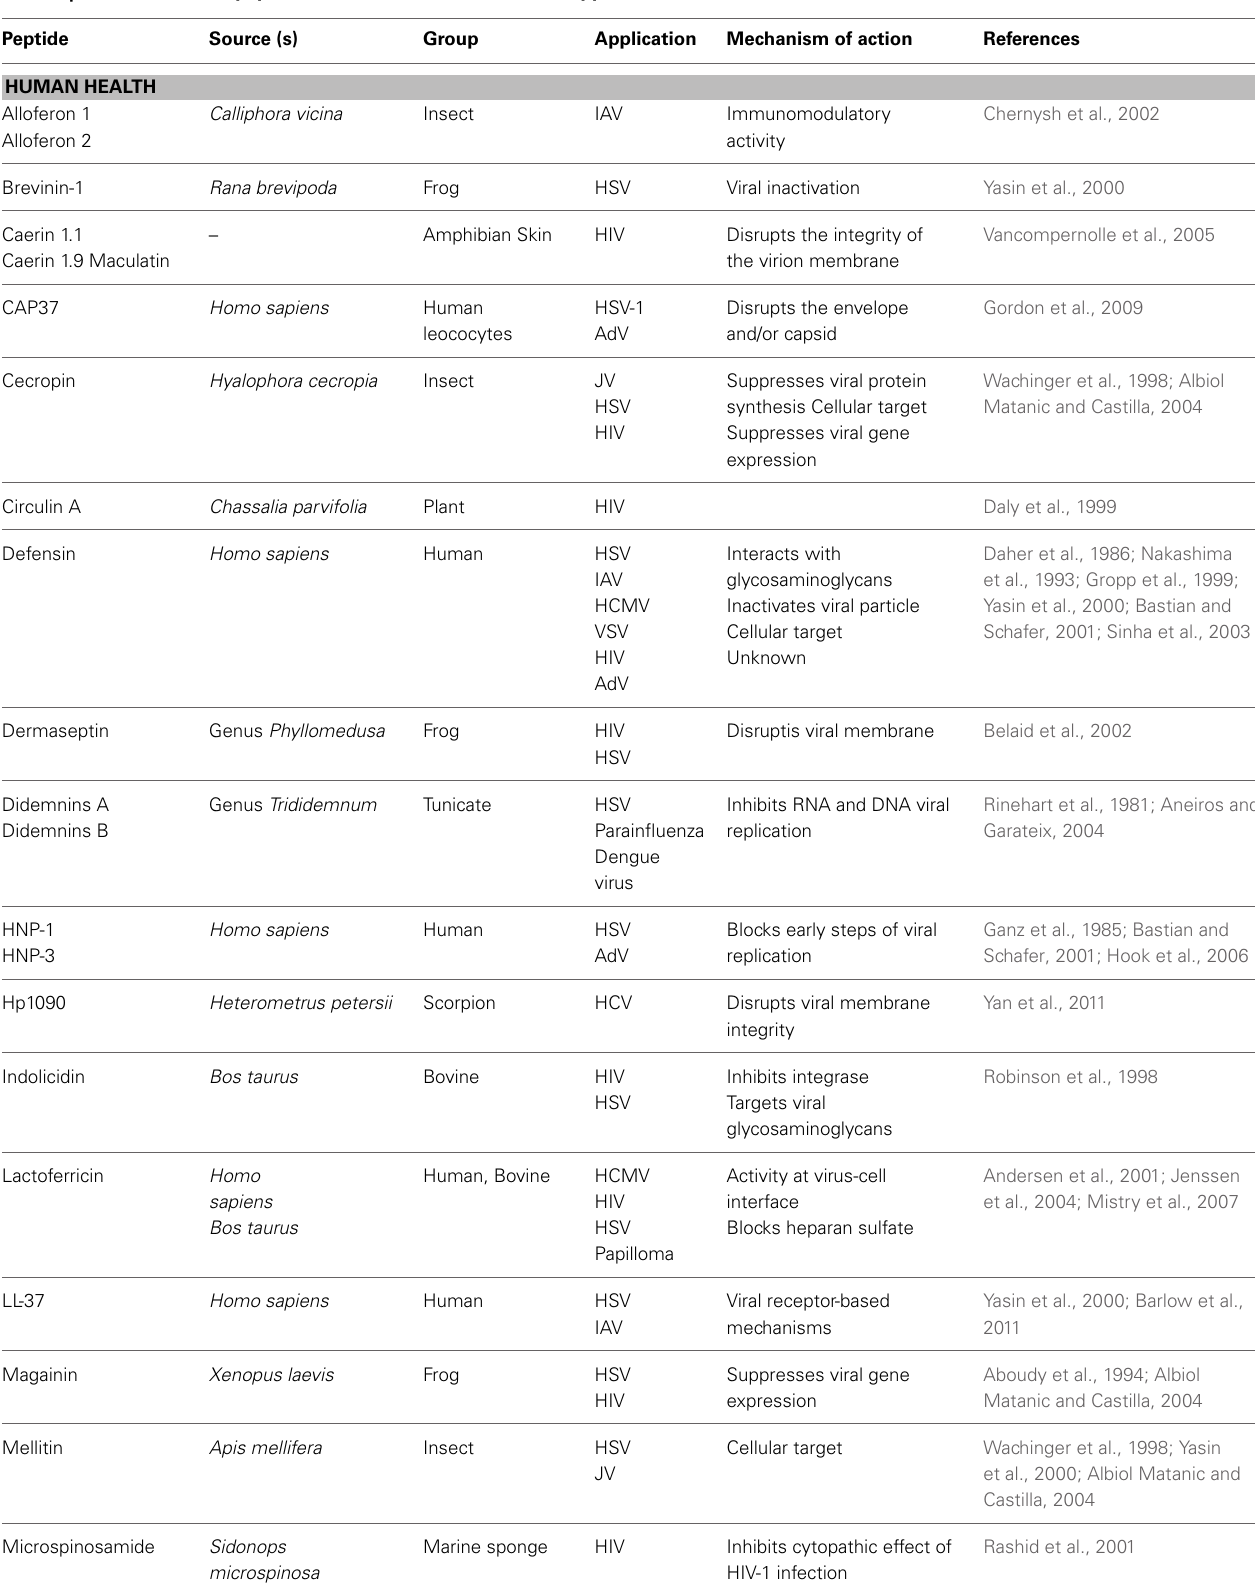
Table 2 | Cationic antiviral peptides from different sources, their application, and their mechanisms of action.